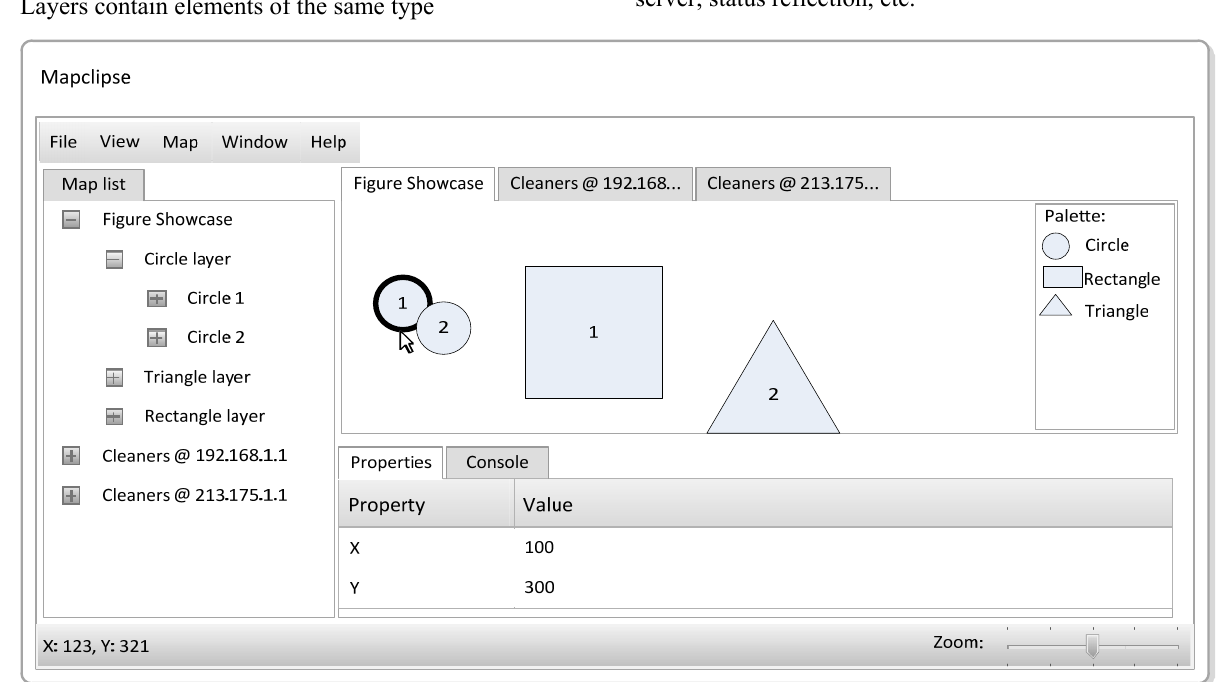
Fig.3. User interface